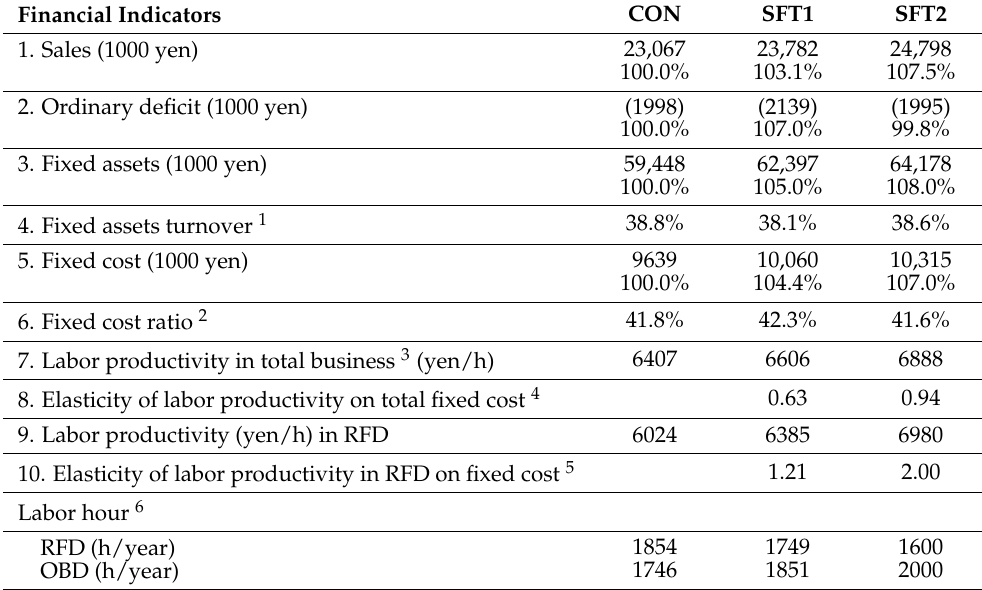
Table 4. Financial performance analysis